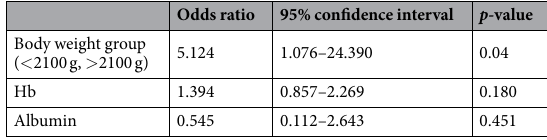
Table 6. Multivariable